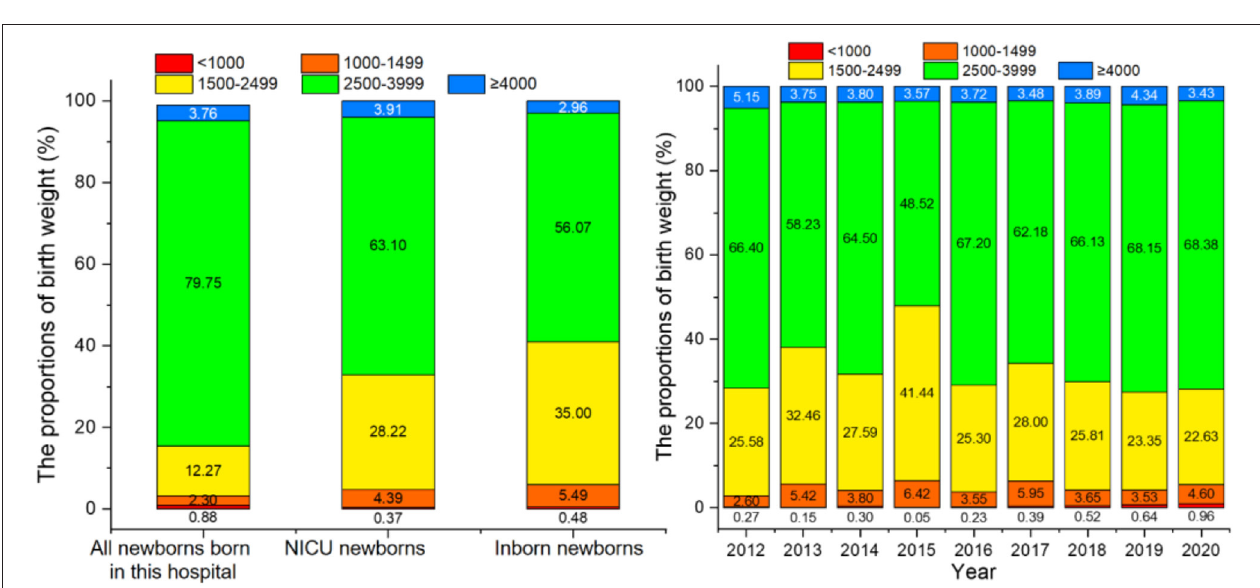
Frontiers in Pediatrics |